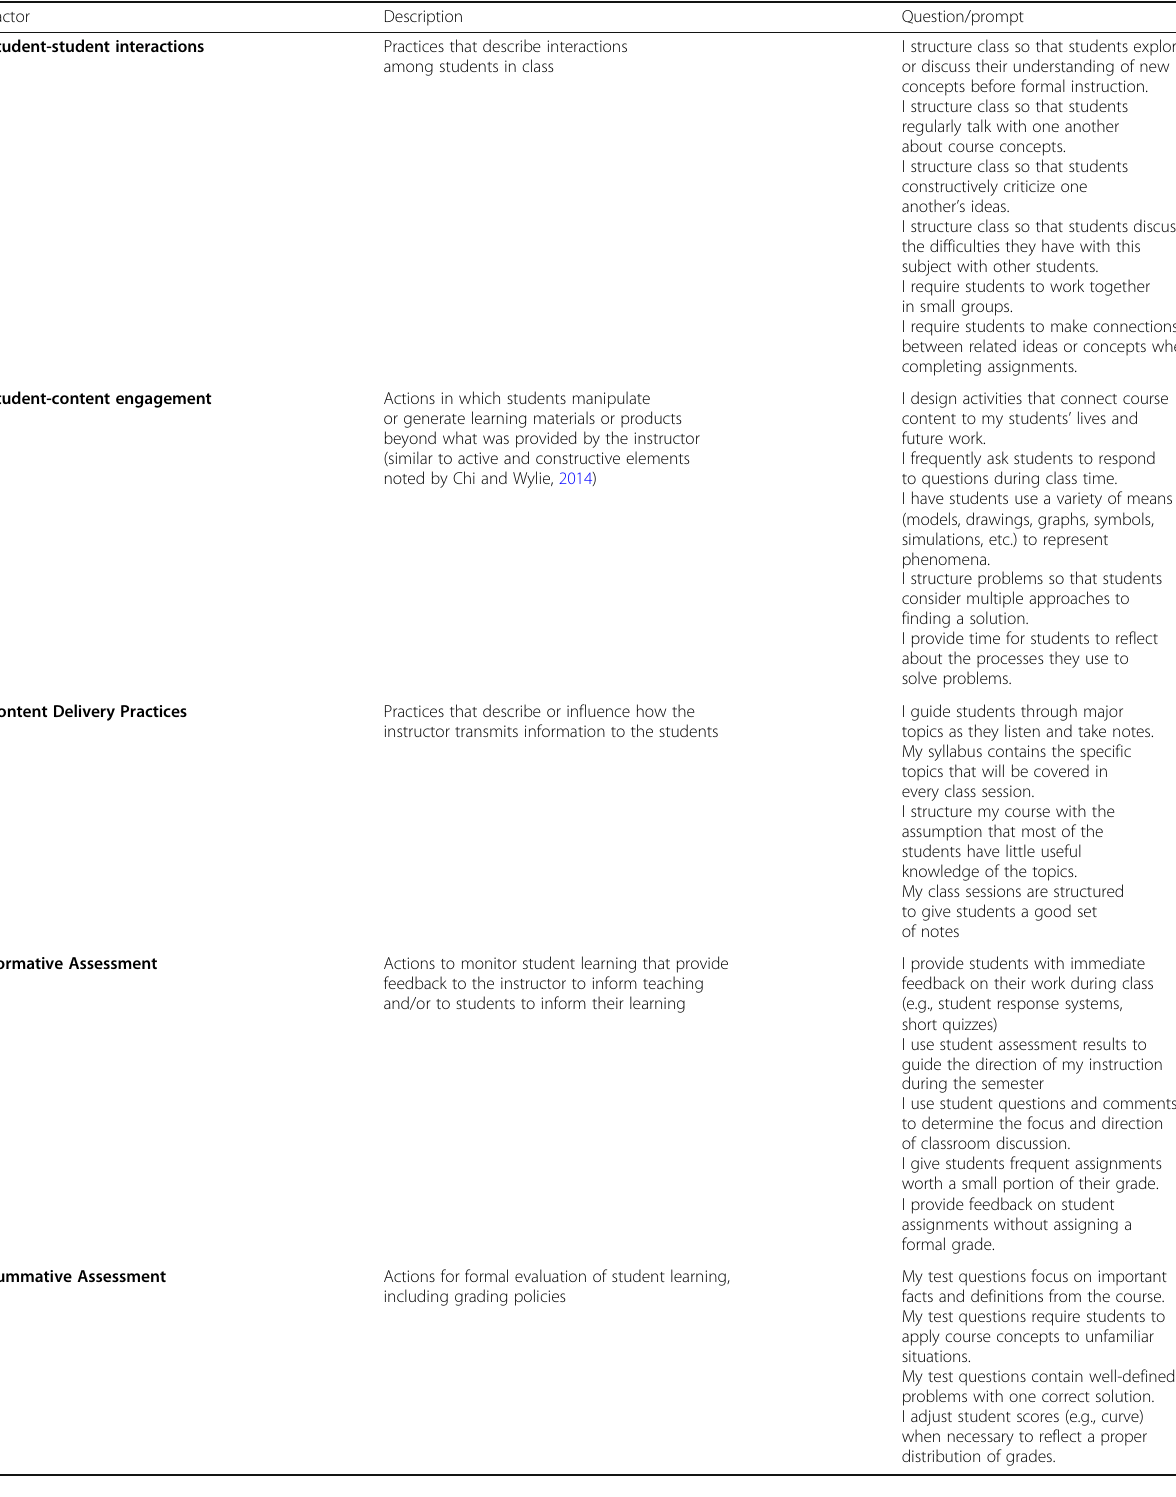
Table 3 The 5-factor model of the PIPS